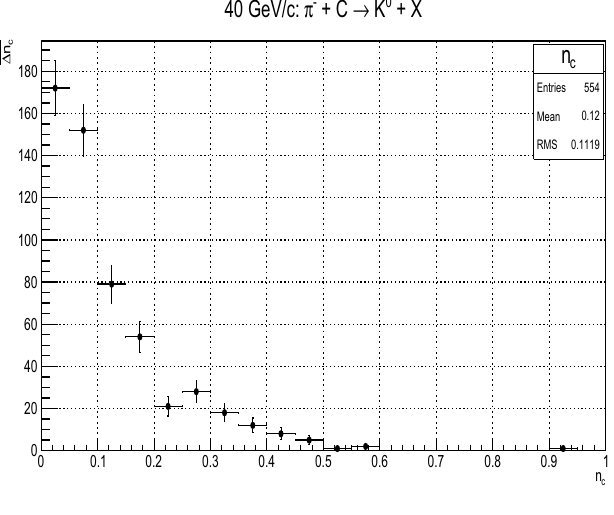
Figure 3. Cumulative number n c distribution of K 0 mesons